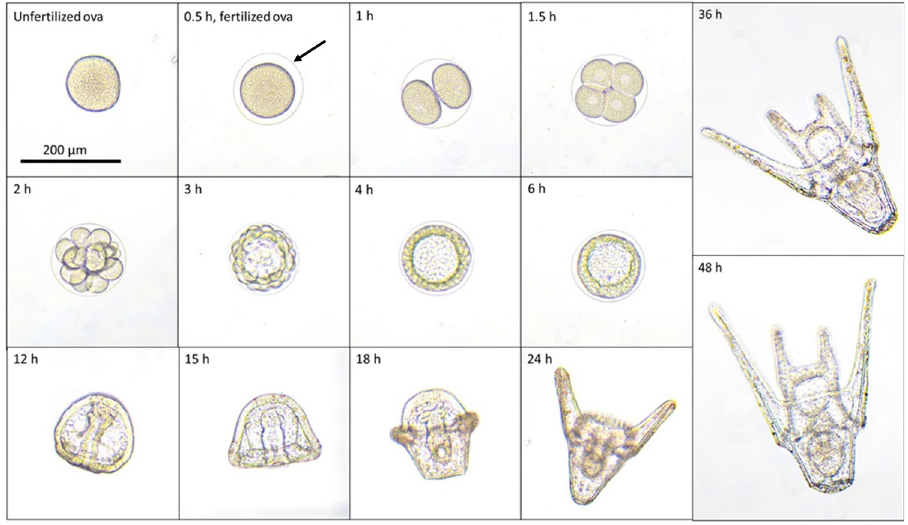
Fig 1. The developmental stages of Lytechinus variegatus at 26˚C. The time post fertilization (pf) is shown in the upper left corner of each image. Fertilization occurs within 30 min after male and female gametes are mixed together (indicated by the presence of a fertilization membrane, black arrow). Cell-stage embryos (2–64 cells) develop between 1–2 h pf. Blastulas are evident between 3–6 h pf and gastrulation is completed by 12 h pf. Prism stage is observed at 15 h pf. At 18–24 h pf, two arms appear and elongate, indicating the early pluteus developmental stage. By 36–48 h pf, the embryo has developed into a four-armed pluteus.